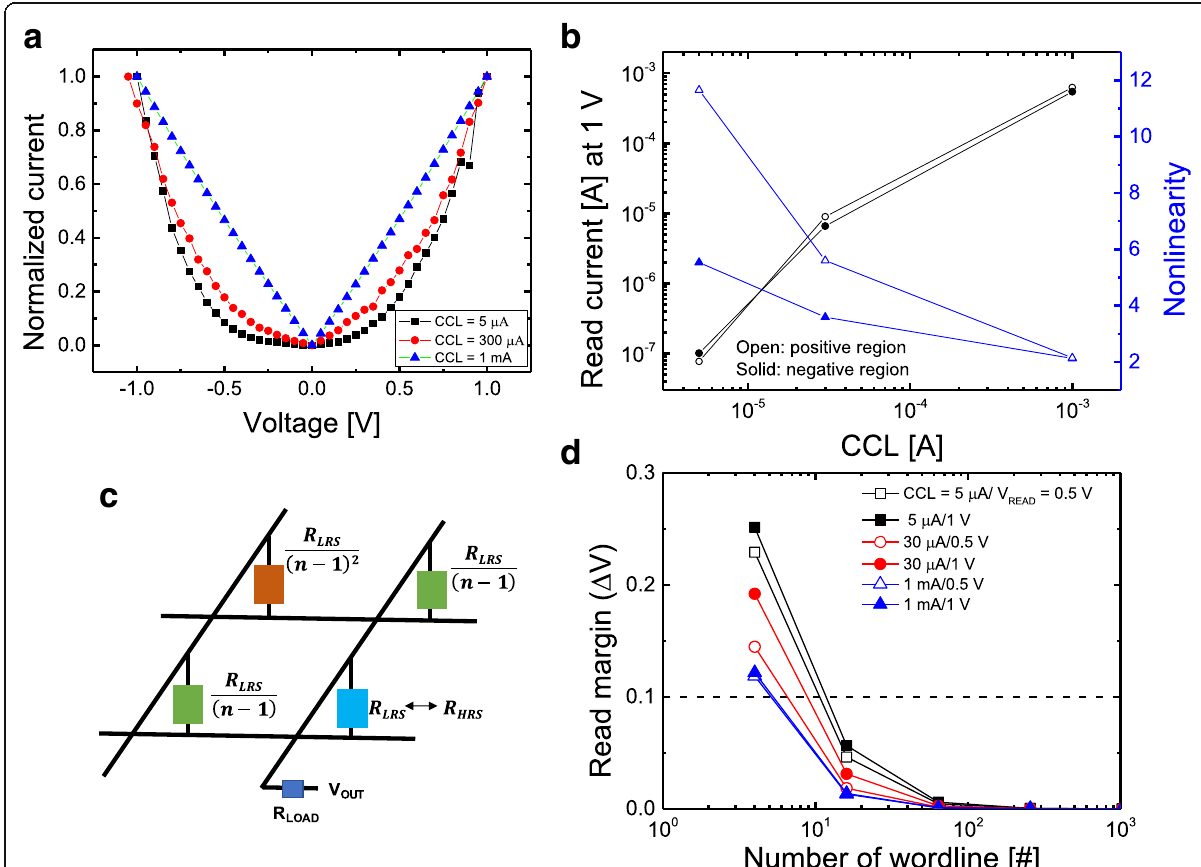
Fig. 4 Nonlinear characteristics of V/SiO x /AlO y /p ++ Si for memory switching. a I – V curves with different CCLs. b Read current and nonlinearity as functions of CCL. c Equivalent circuits of cross-point array. d Read margin as a function of word line number for different CCLs and read